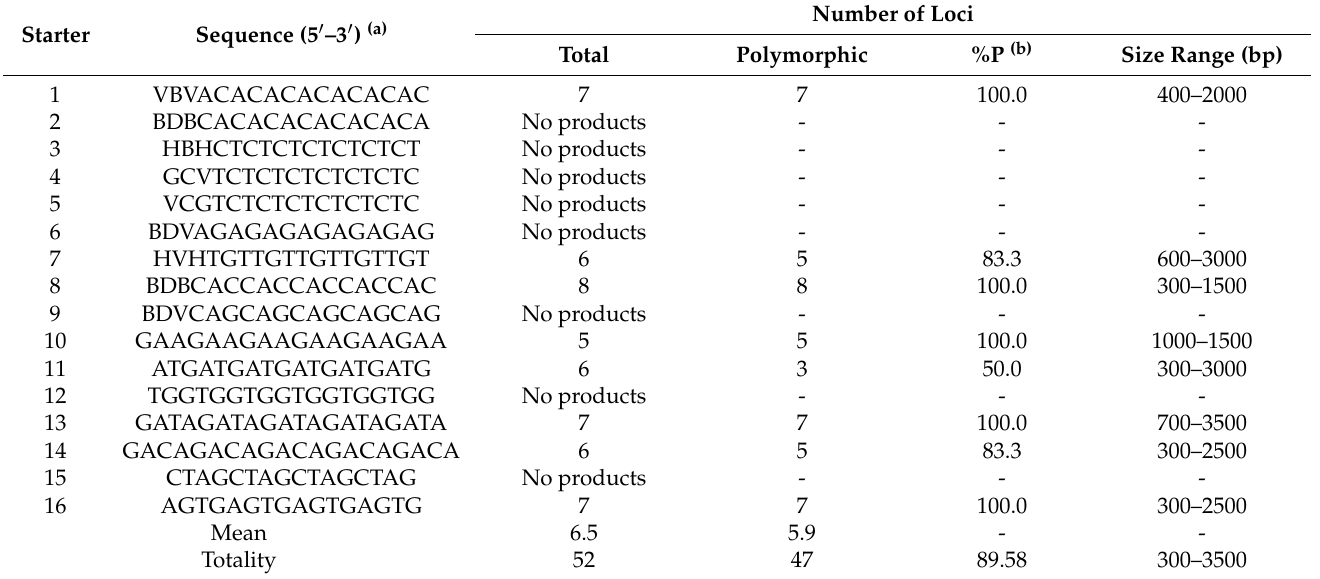
Table 1. DNA polymorphism of the studied strawberry genomes using ISSR